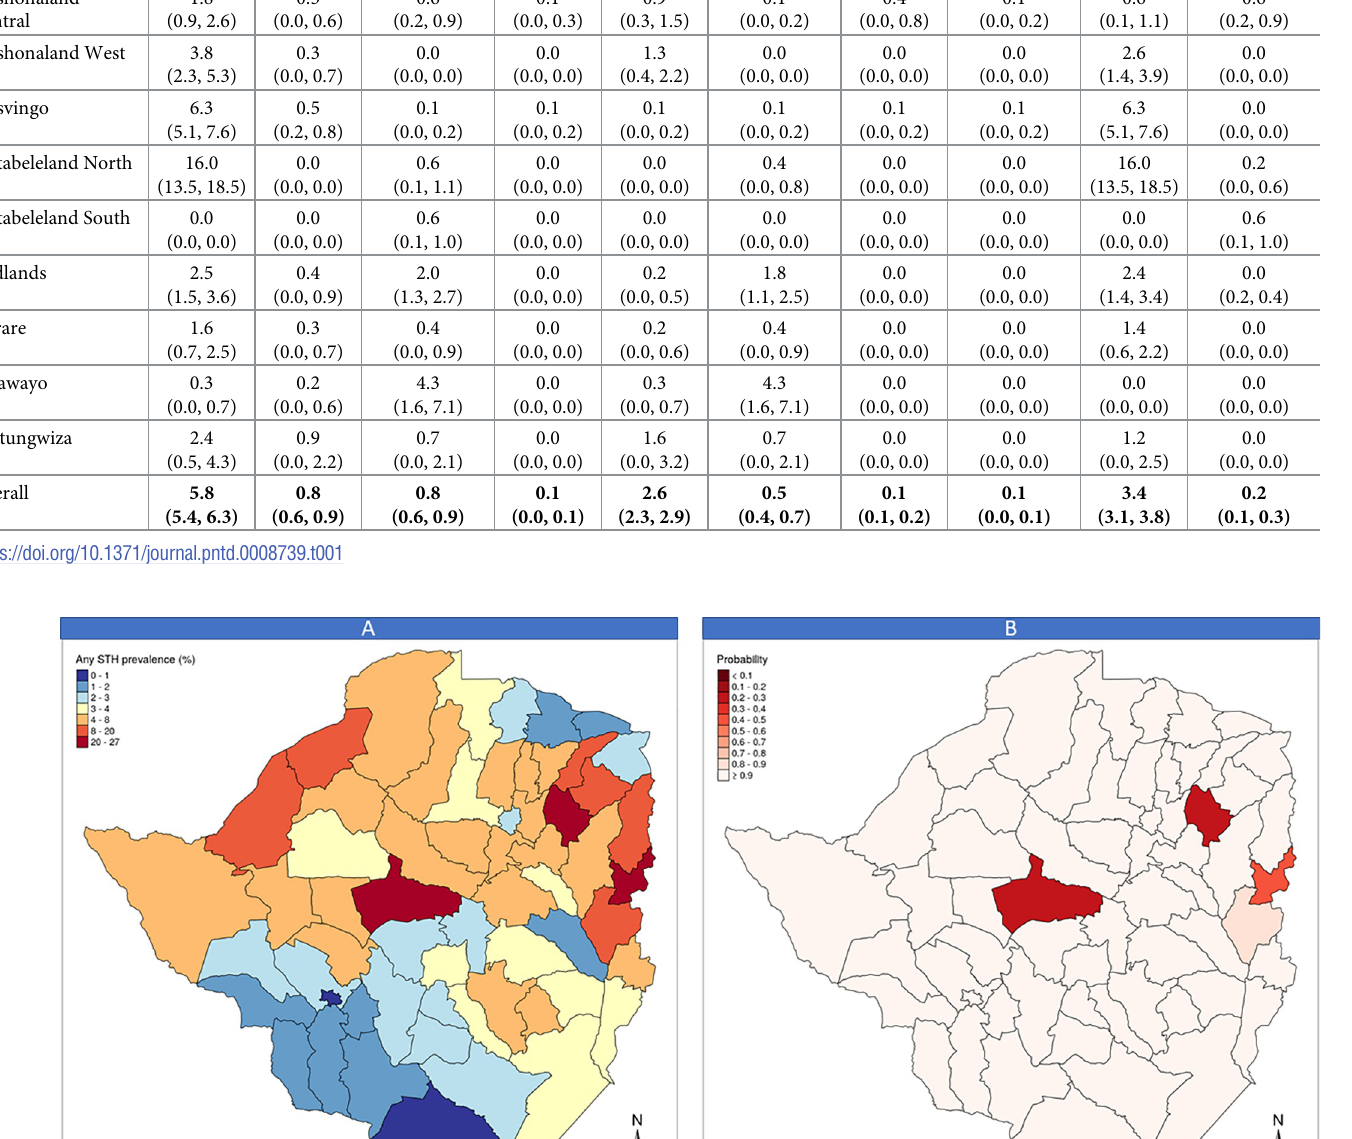
PLOS NeglectedTropical Diseases | https://doi.org/10.1371/journal.pntd.0008739 October 23, 2020 7 /